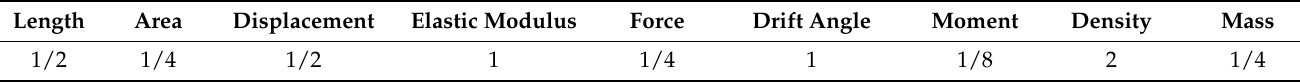
Table 1. Scale factors of the physical